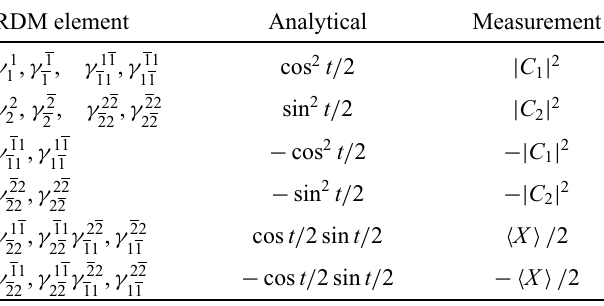
TABLE VI. The relations between the elements of the fermionic 1-RDM and